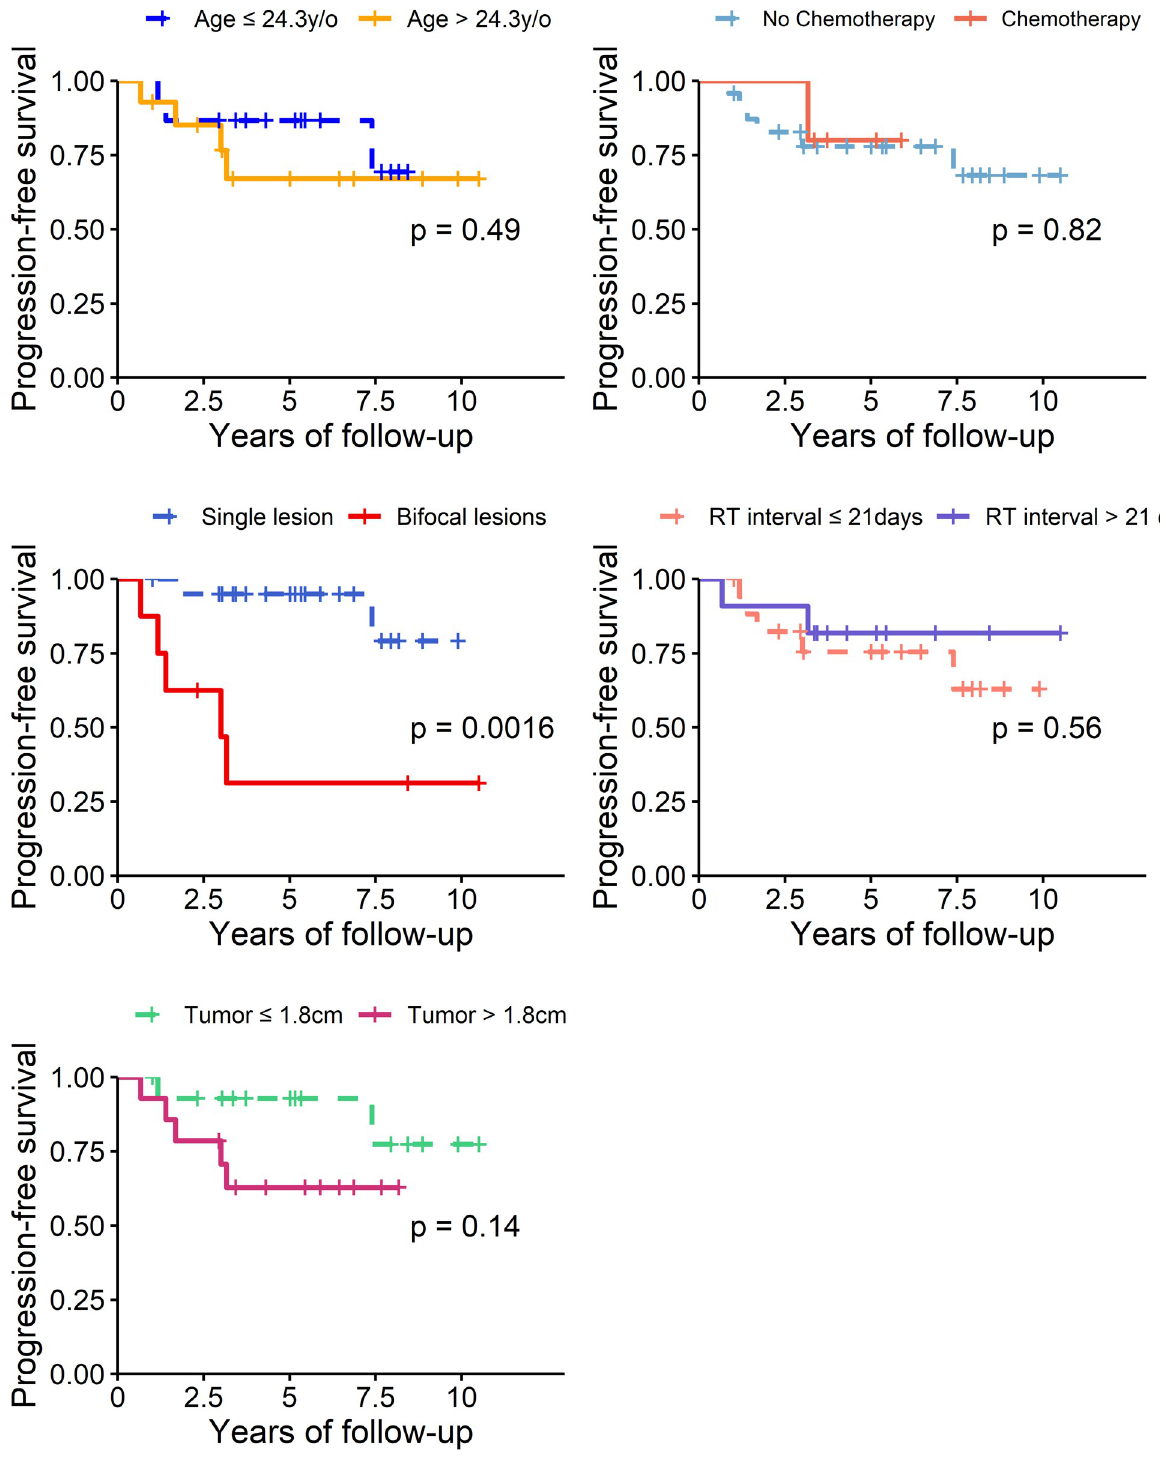
Fig 3. Comparison of progression-free survival curves according to different prognostic factors estimated with the Kaplan-Meier method.